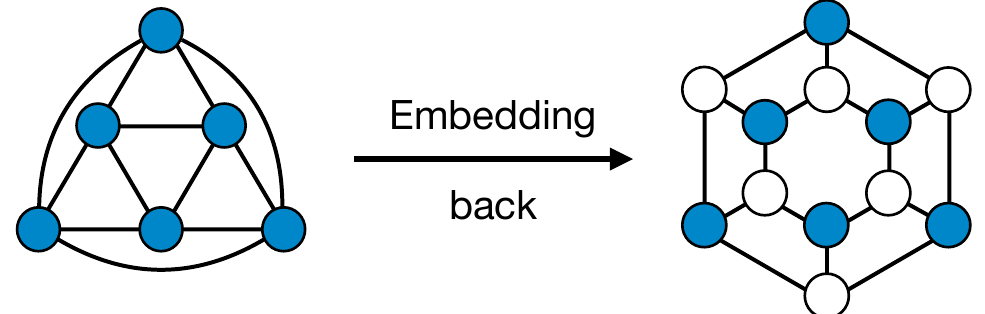
Figure 2. Un-Pooling. The Un-Pool operation consists in embedding the nodes of a pooled graph in their initial position in the bigger original graph structure. All other restored nodes are initialized to